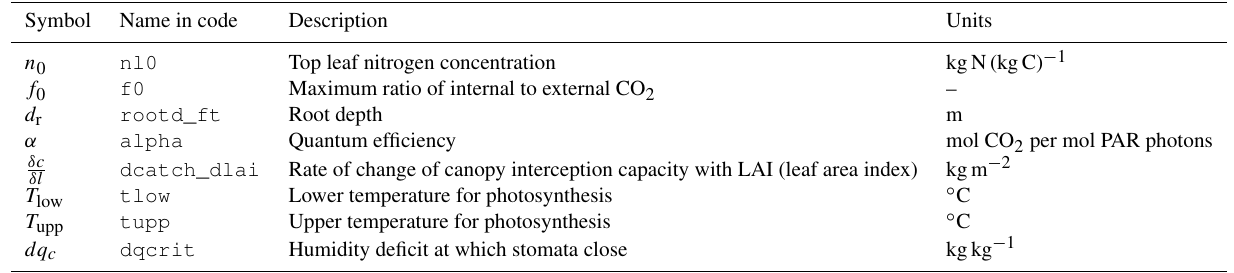
Table 1. Parameters in optimisation vector, with descriptions.